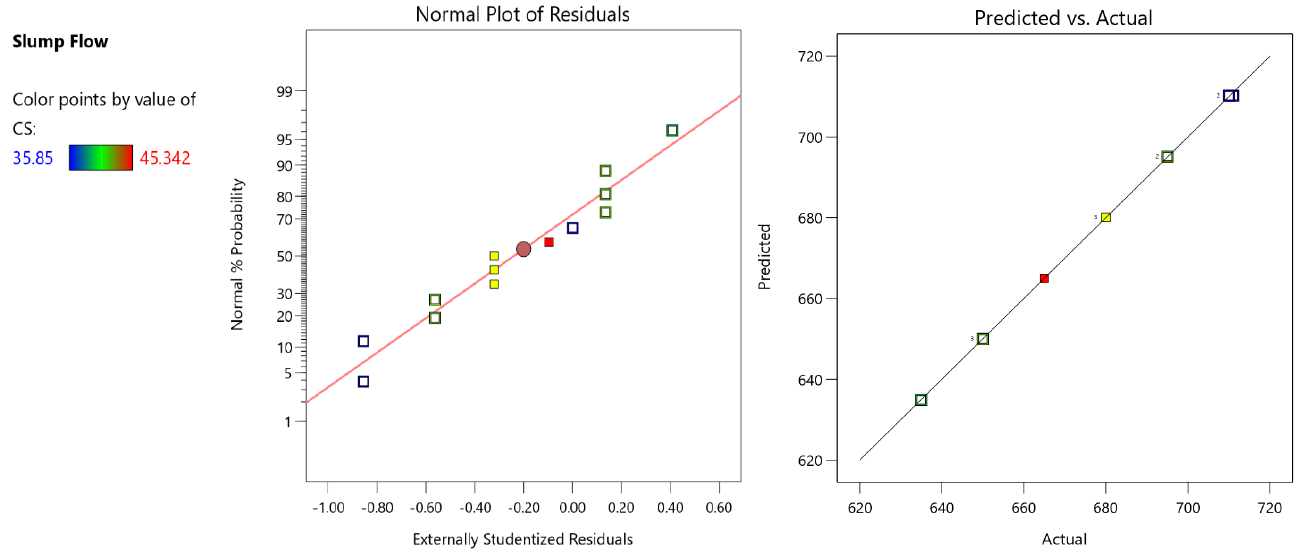
Figure 13. Normal plot for residuals, and actual vs. predicted values for slump.